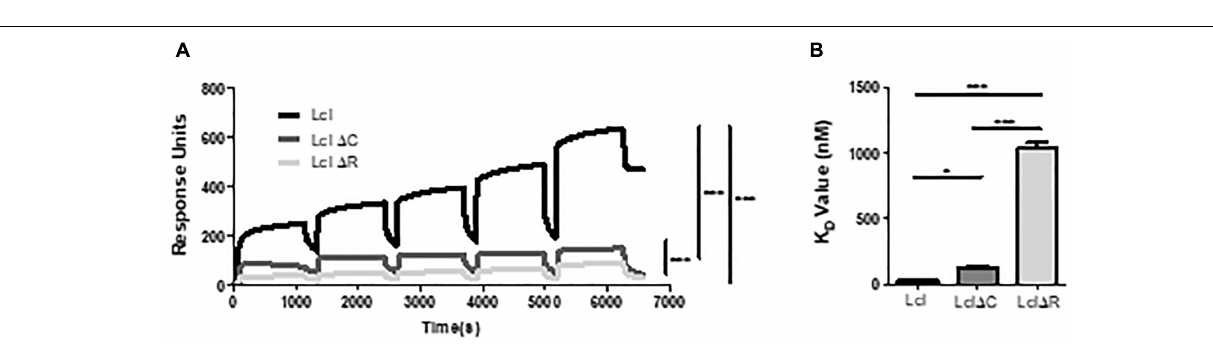
FIGURE 4 | Lcl oligomerizes through homotypic binding of the R and C domains. (A,B) Surface plasmon resonance sensorgrams for single-cycle injection analysis of the interaction between His-tagged Lcl, His-tagged Lcl (cid:49) R and Lcl (cid:49) C against GST-tagged Lcl immobilized on anti-GST modified Biacore TM sensor chips (A) and their associated calculated K D values (B) . Plotted values are the average of 3 individual experiments, ∗ and ∗∗∗ denotes p < 0.05 and p < 0.001, respectively, by one-way